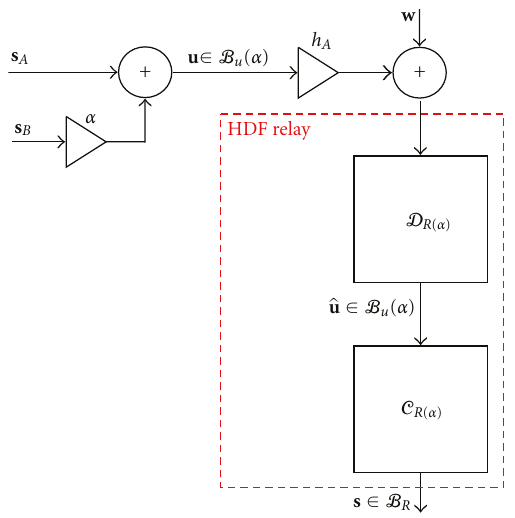
Figure 3: Equivalent model of HDF strategy relay processing in parametric channel.